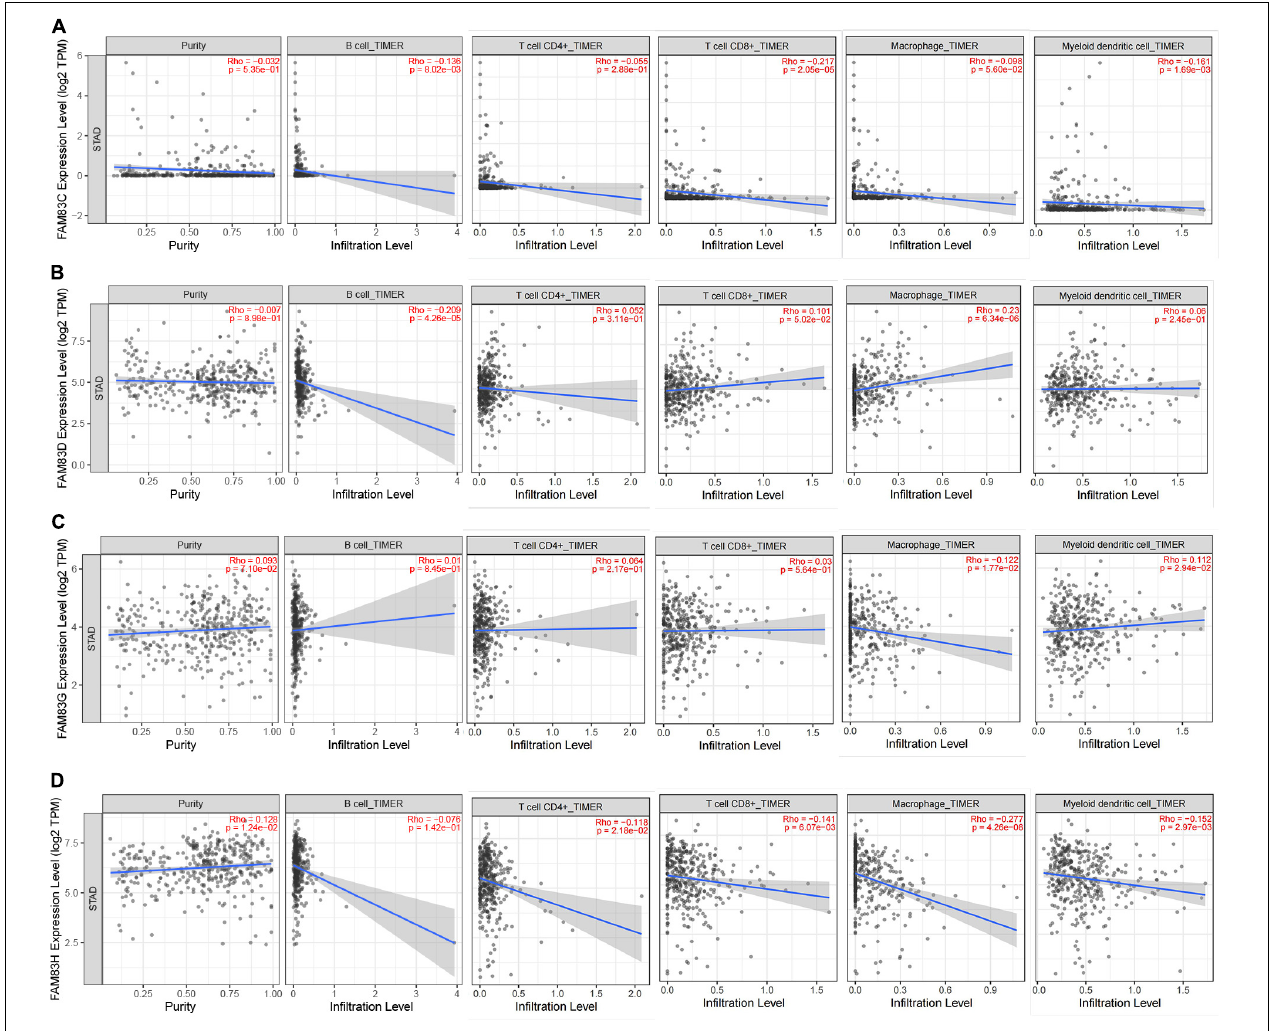
FIGURE 12 | (A–D) The correlation between different expressed FAM83 family members and immune cell infiltration